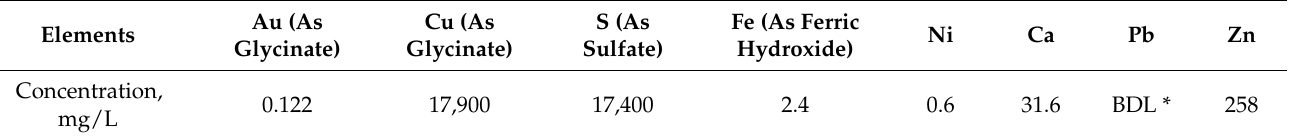
Table 8. Elemental assay of final leachate at 10% solid content.